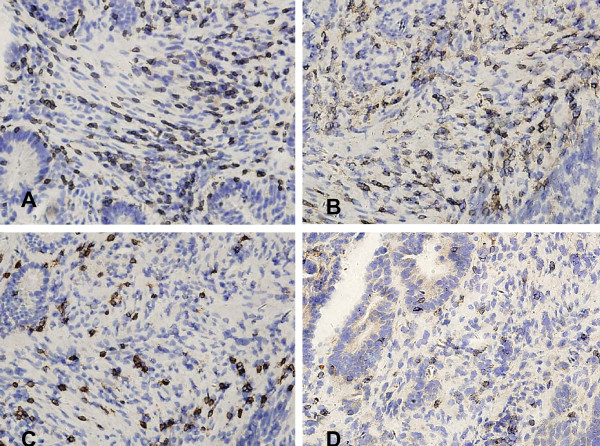
Subtype of CD3+ cells within stage IIIB colon cancer tissues. A high density of CD3+ cells infiltrated into the colon cancer stroma (×400, A); CD4+ cells infiltrated into the colon cancer stroma (×400, B), CD8+ cells infiltrated into the colon cancer stroma (×400, C), and CD56+ cells infiltrated into the colon cancer stroma (×400, D). All of the antigens were immunolocalized to the membrane.